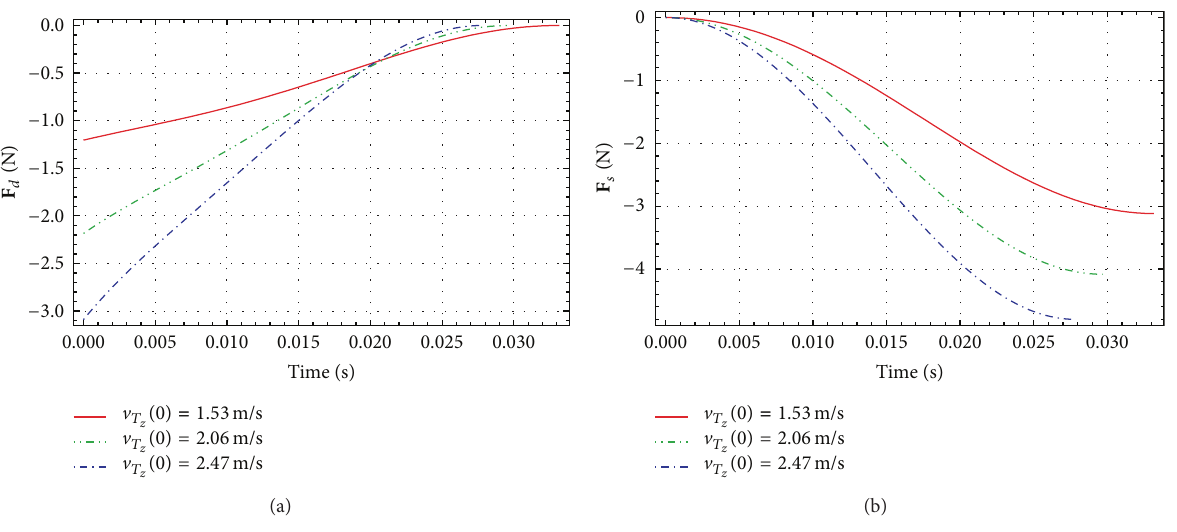
Figure 5: Resistance forces F 𝑑 and F 𝑠 .